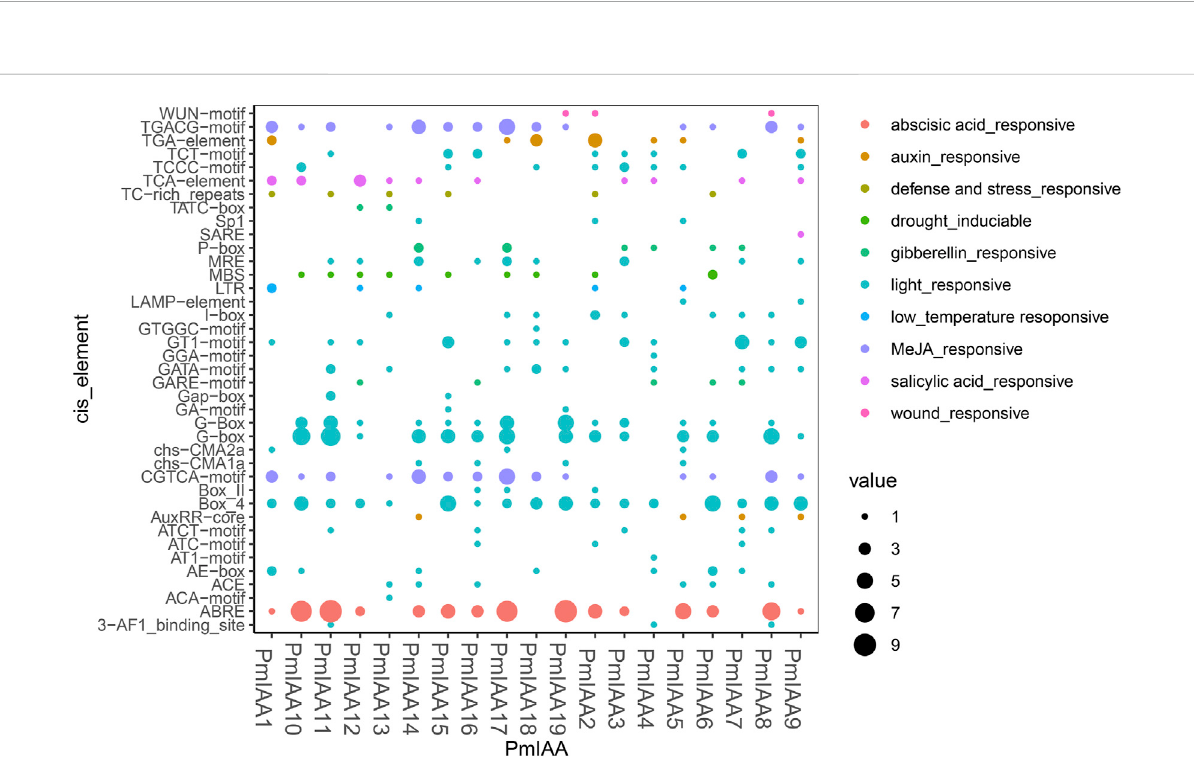
FIGURE 4 Promoter sequence analysis reveals the functional cis-acting elements involved in stress-responsive and hormonal signaling. The x -axis represents PmIAA genes and the y -axis indicates the number of each kind of cis-acting element within each PmIAA